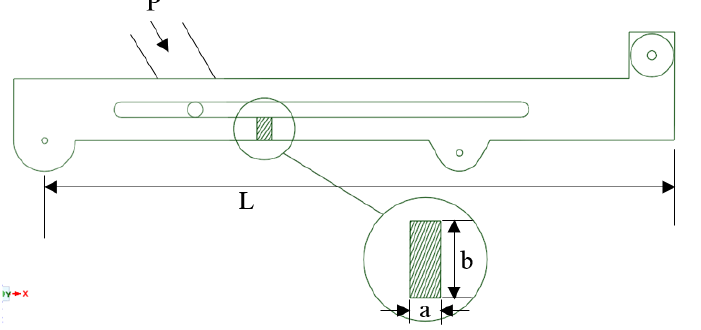
Figure 9. Cross sectional area under